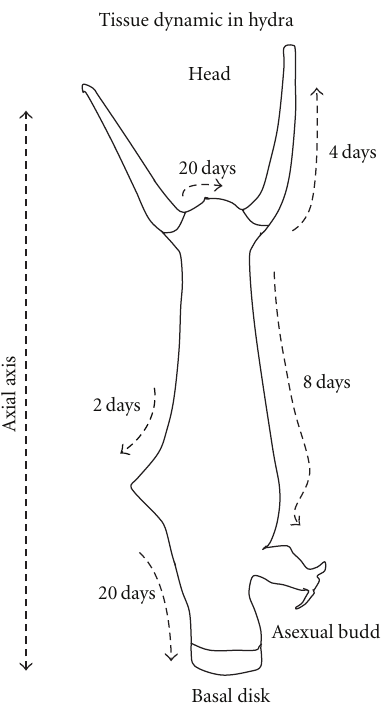
Figure 1: Tissue dynamic in a hydra polyp. Tissue movements were monitored after the insertion of tissue stained with methylene blue at di ff erent points, as described by Campbell [23]. The arrows indicate the direction and route of the tissue movements and the time elapsed. In these animals, cell identity is defined by its position relative to the axial axis, but these positions are not